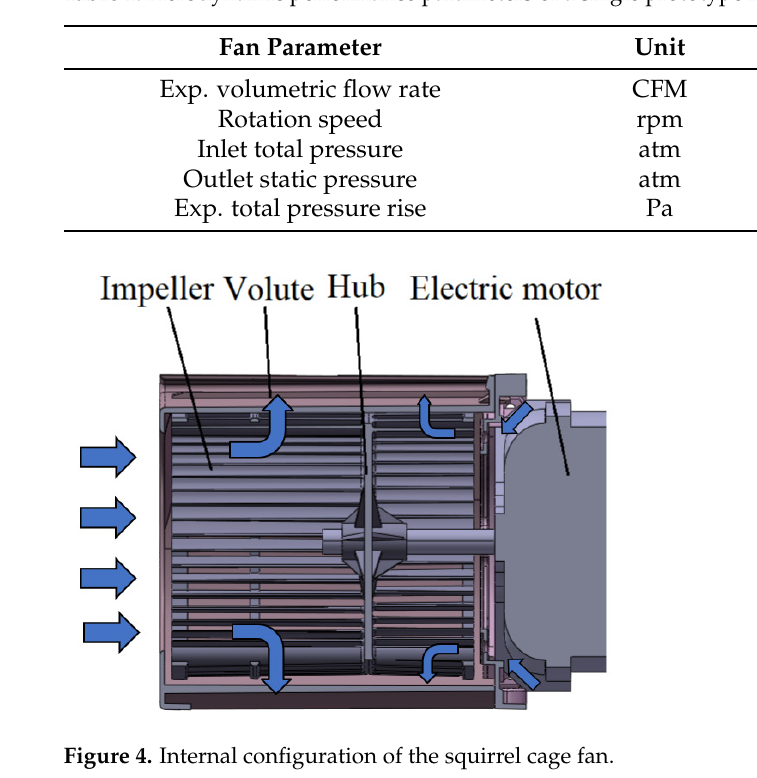
Table 1. Aerodynamic performance parameters of a single prototype fan at MVP.